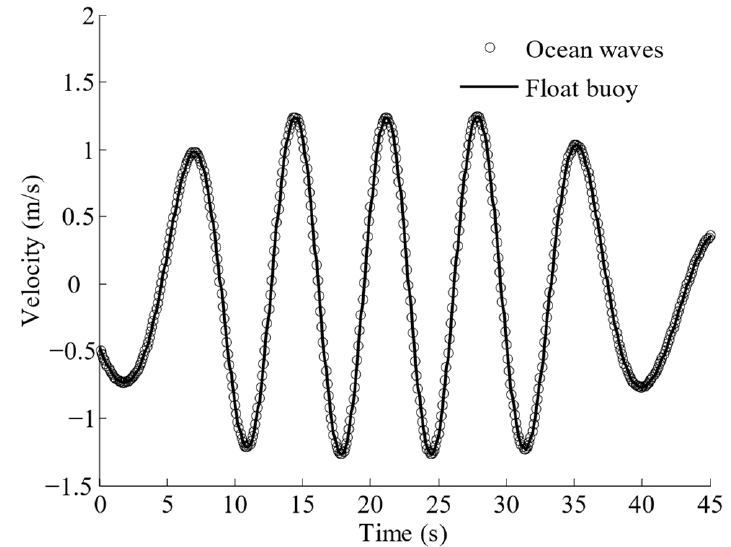
=ε Figure 13. Simulation result of IM-PID control ( 01.0 ). Figure 13. Simulation result of IM-PID control ( ε = 0.01). Figure 13. Simulation result of IM-PID control ( 01.0   ). Some other optimization control methods for ocean wave power generation system are proposed. For example, the maximum power point tracking (MPPT) method